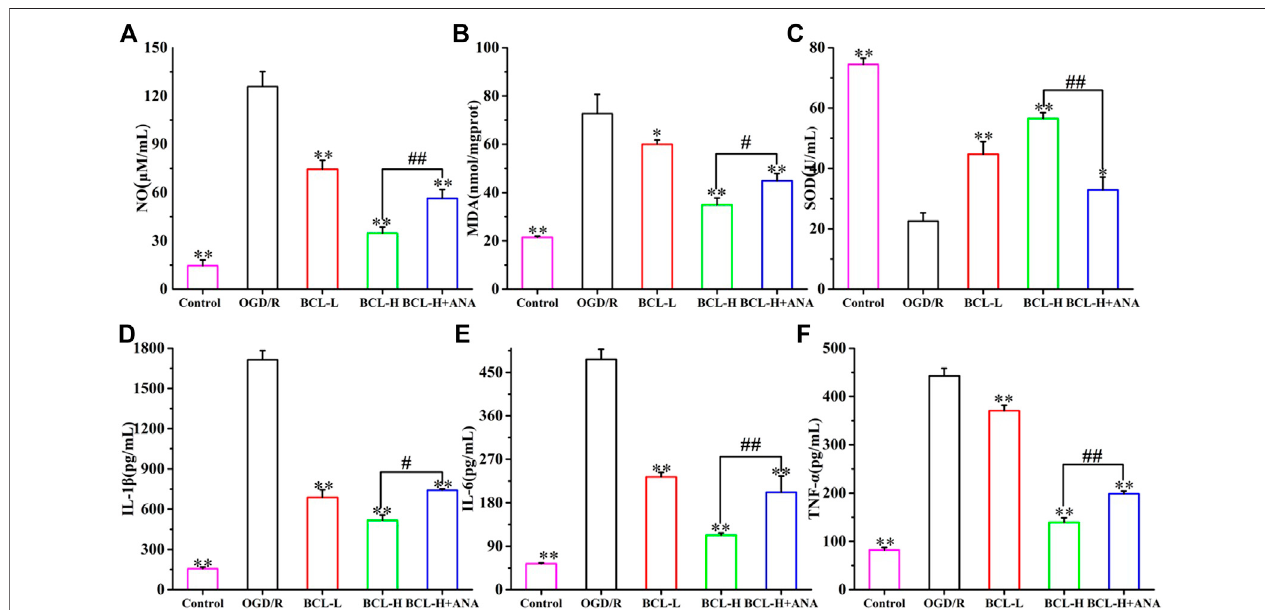
FIGURE9| Effect ofBCL (34.38 μ g/ml,8.59 μ g/ml) onin fl ammation and oxidative/nitrosative stress inthe NAsystem after OGD/R. (A) TheeffectofBCL onNO in theNAsystemafter OGD/R. (B) Theeffect ofBCLonMDAintheNAsystemafter OGD/R. (C) Theeffect ofBCLon SODintheNAsystemafterOGD/R. (D) Theeffectof BCL on the IL-1 β level inthe NA system after OGD/R. (E) The effectof BCL on IL-6 in the NAsystem after OGD/R. (F) The effect ofBCL on TNF- α in the NA system after OGD/R. ** p < 0.01, * p < 0.05, vs. OGD/R group; # p < 0.05, ## p < 0.01, BCL-H group vs. BCL-H+ANA group.